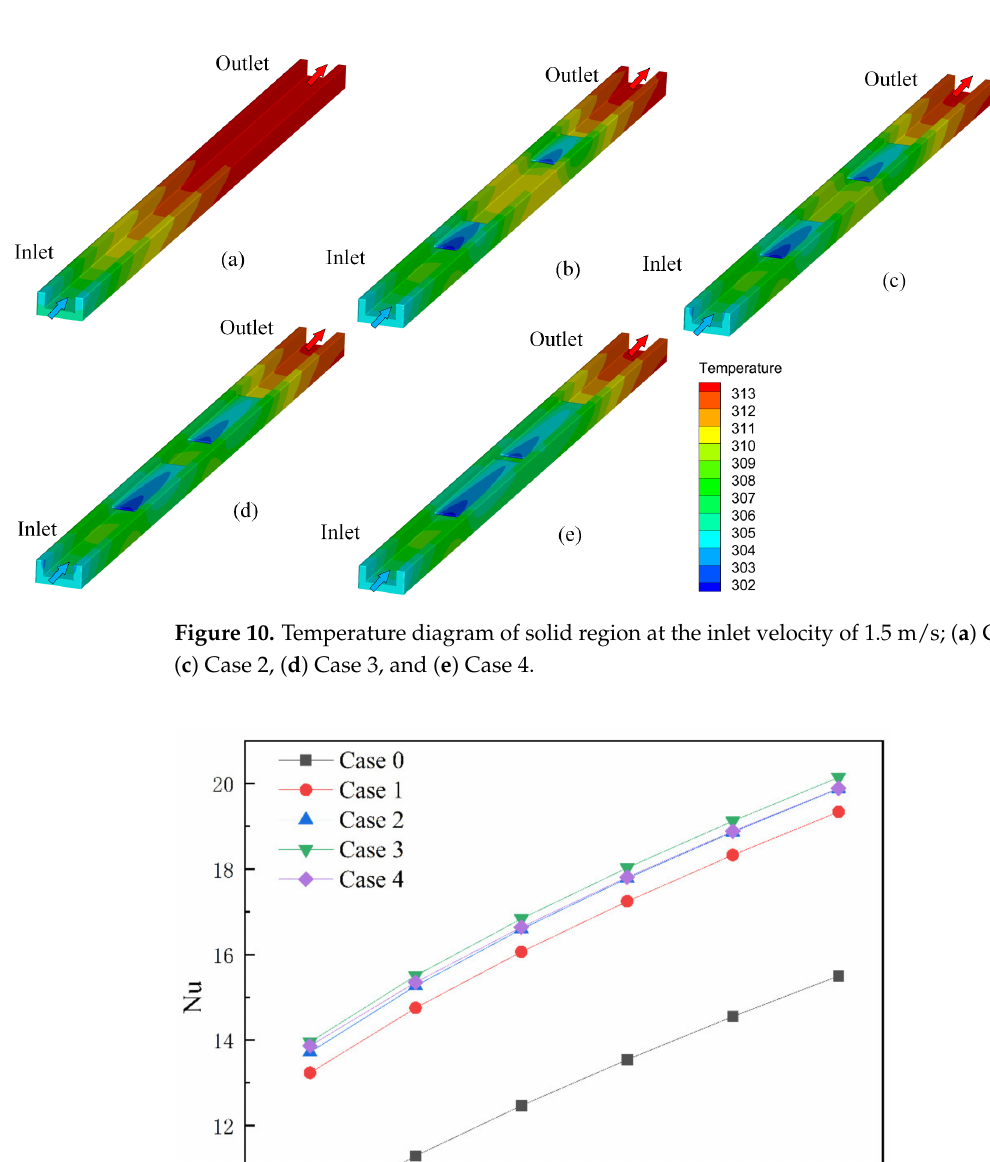
Figure 11. Nusselt number of Cases 0–4 at different Reynolds numbers.